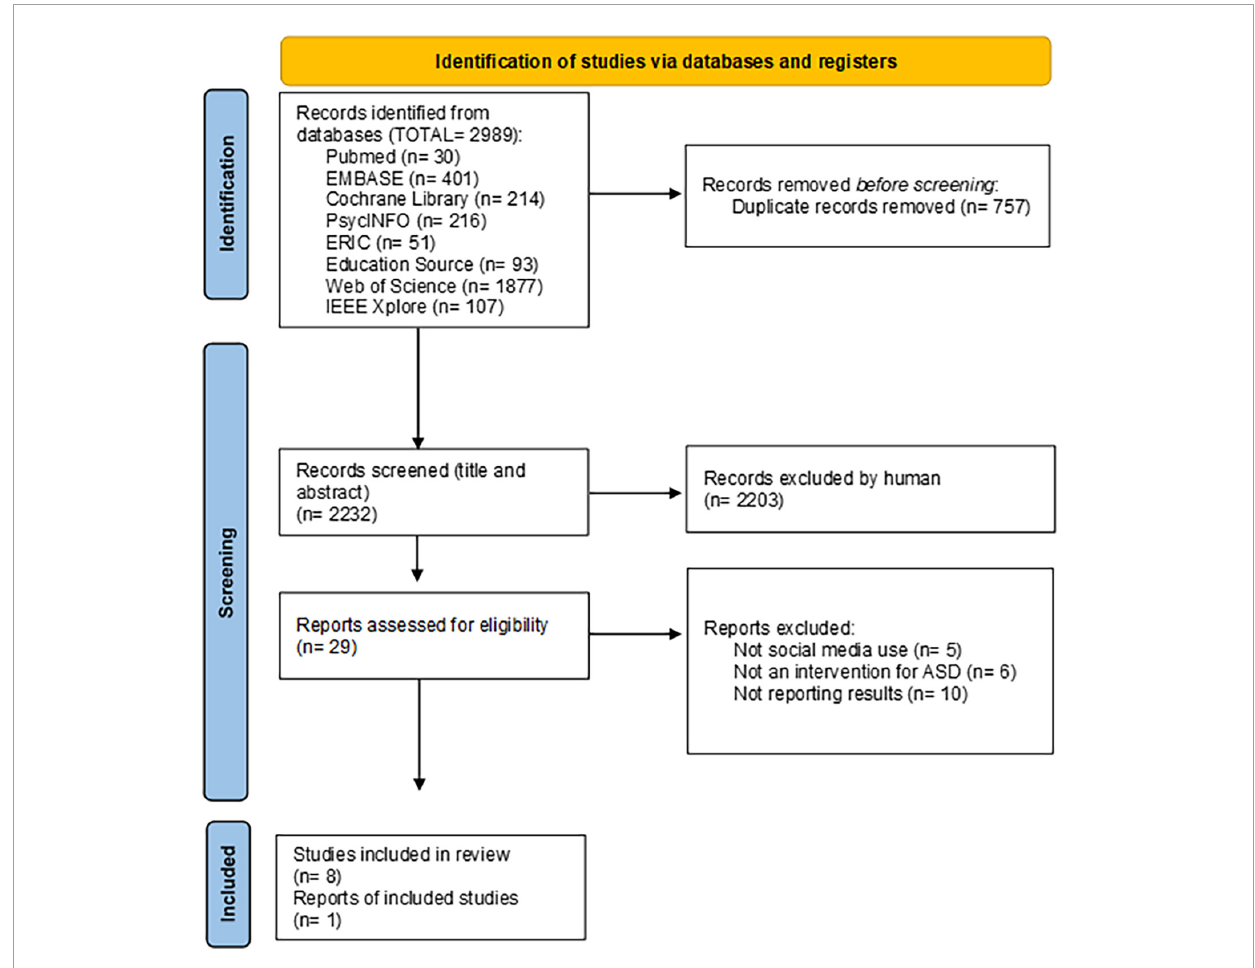
FIGURE1 Flowchart of the selection